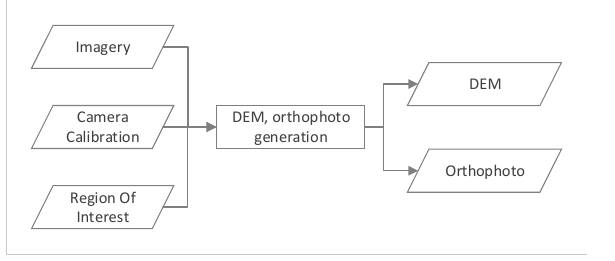
Figure 7. DEM and orthophoto generation